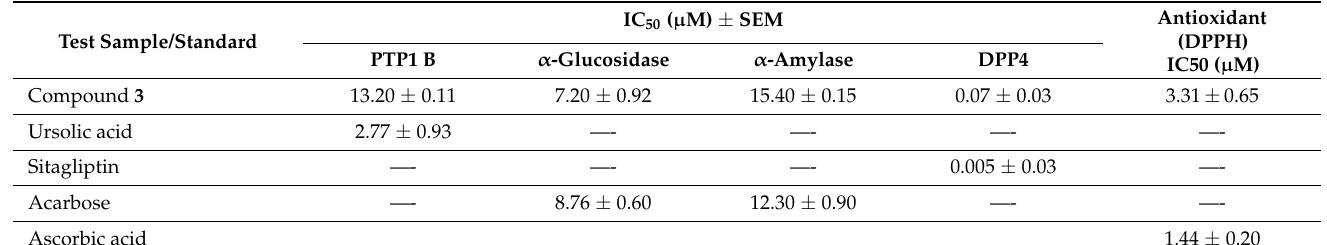
Table 1. Compound 3 ’s IC 50 values using in vitro assays.